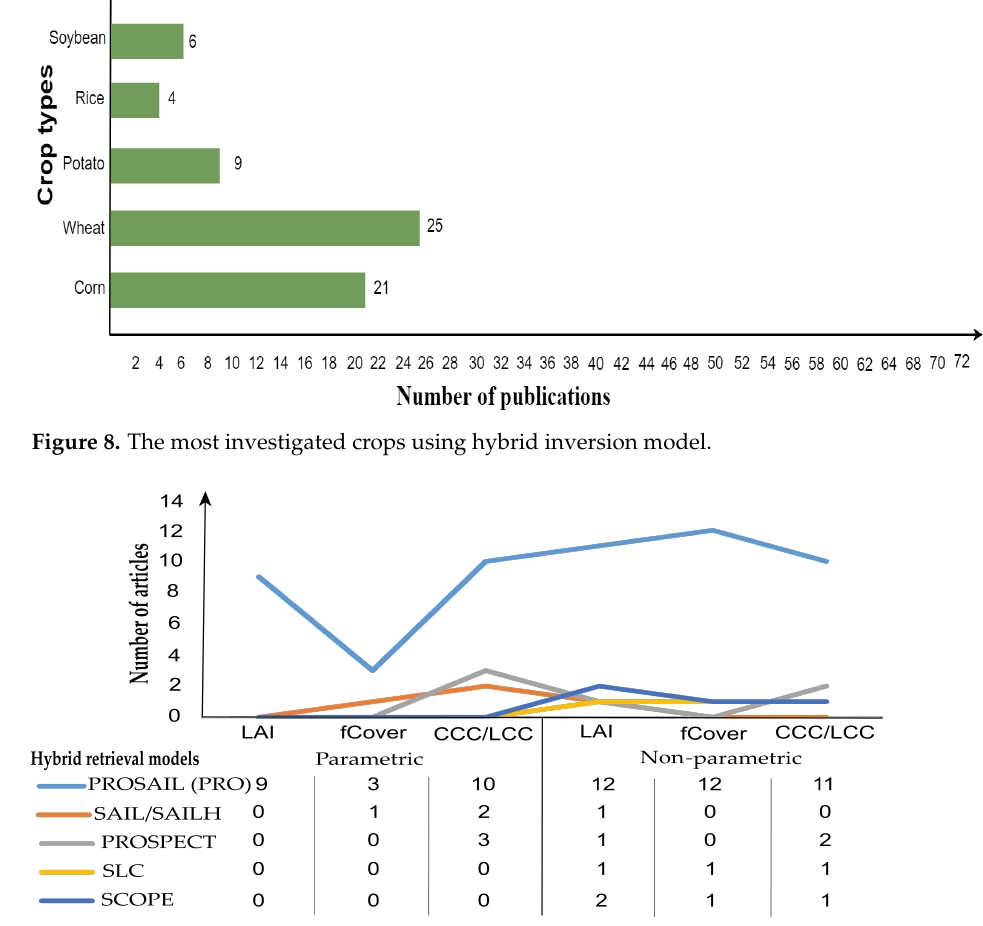
Figure 9. Number of publications that used radiative transfer models within the period of